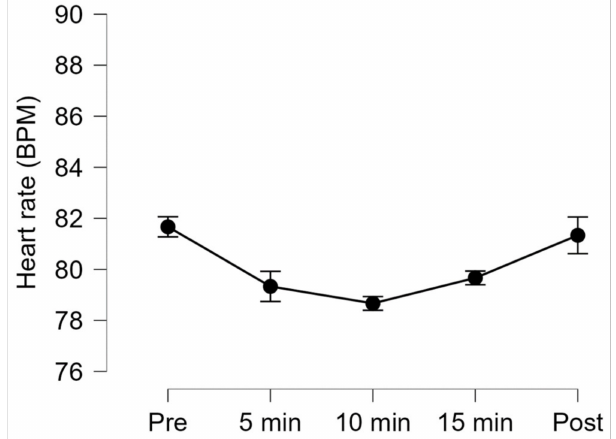
Figure 2. Heart rate values (Mean ± SEM) at different time points before, during, and following iVR exposure to relaxing scenarios.